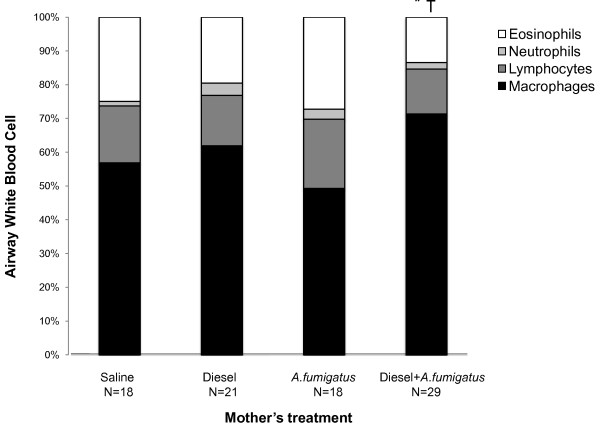
Differential airway cell counts in offspring after five and six doses of A. fumigatus. Eosinophil counts were significantly decreased (and macrophages significantly increased) among offspring from mothers following diesel exhaust and A. fumigatus compared to offspring of mothers treated with saline alone, * p < 0.0002 on ANOVA and p < 0.05 by Tukey HSD or with A. fumigatus alone, † p < 0.0003 on ANOVA and p < 0.01 by Tukey HSD.